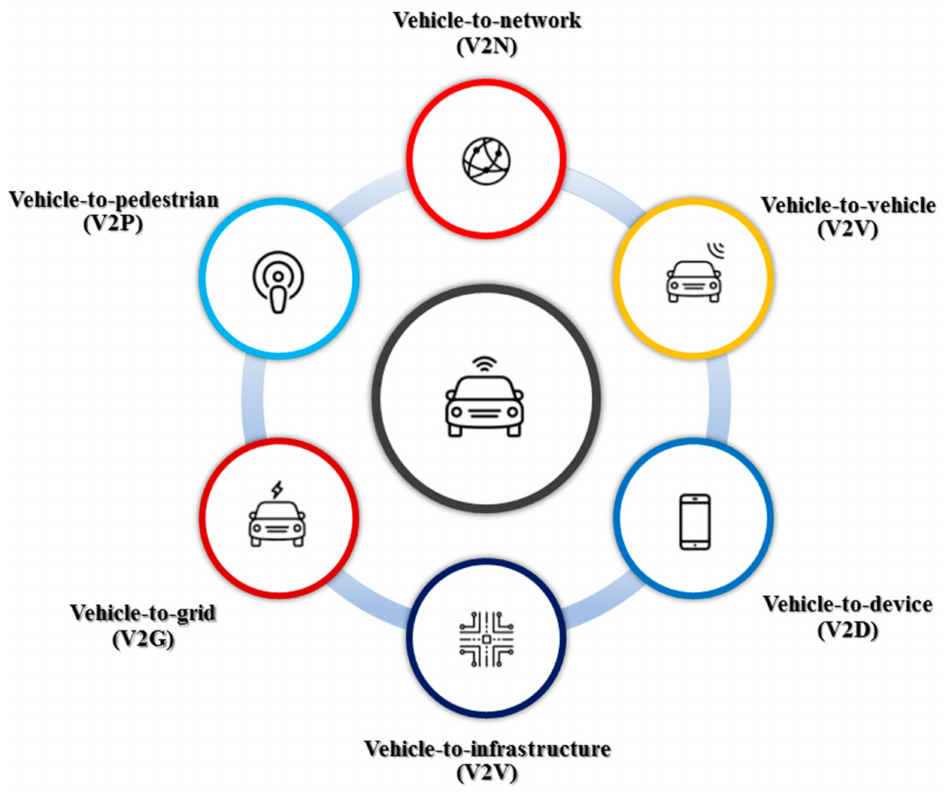
Figure 8. Vehicle-to-everything (V2X)